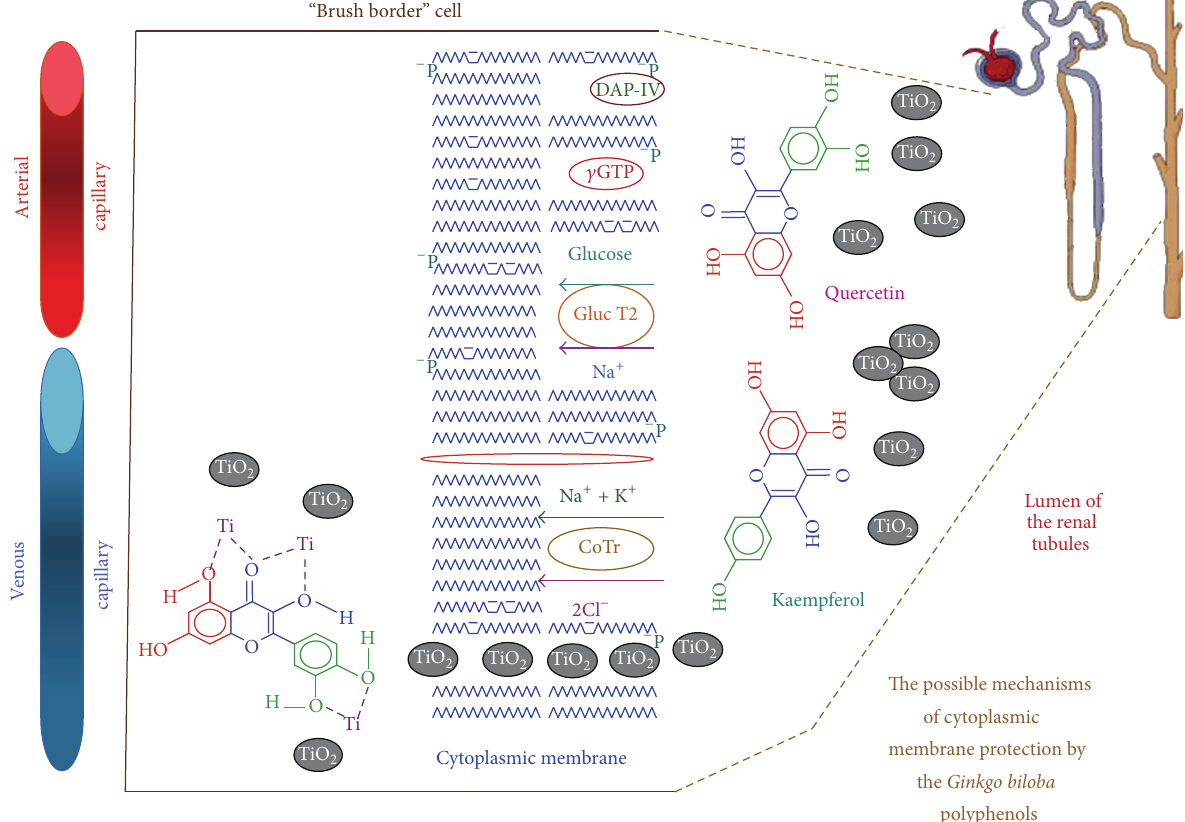
Figure 6: Scheme on the possible mechanisms of the GbE polyphenols for the renoprotection of the cytoplasmic membrane against the effects generated by the TiO 2 nanoparticles, at the luminal side of the brush border cells, along the renal tubules of rat kidneys. 𝛾 GT: 𝛾 -glutamyltranspeptidase, DAP-IV: dipeptidylaminopeptidase IV, CoT: electroneutral Na-K-Cl cotransporter, and Gluc T2: Glucose-Na cotransporter